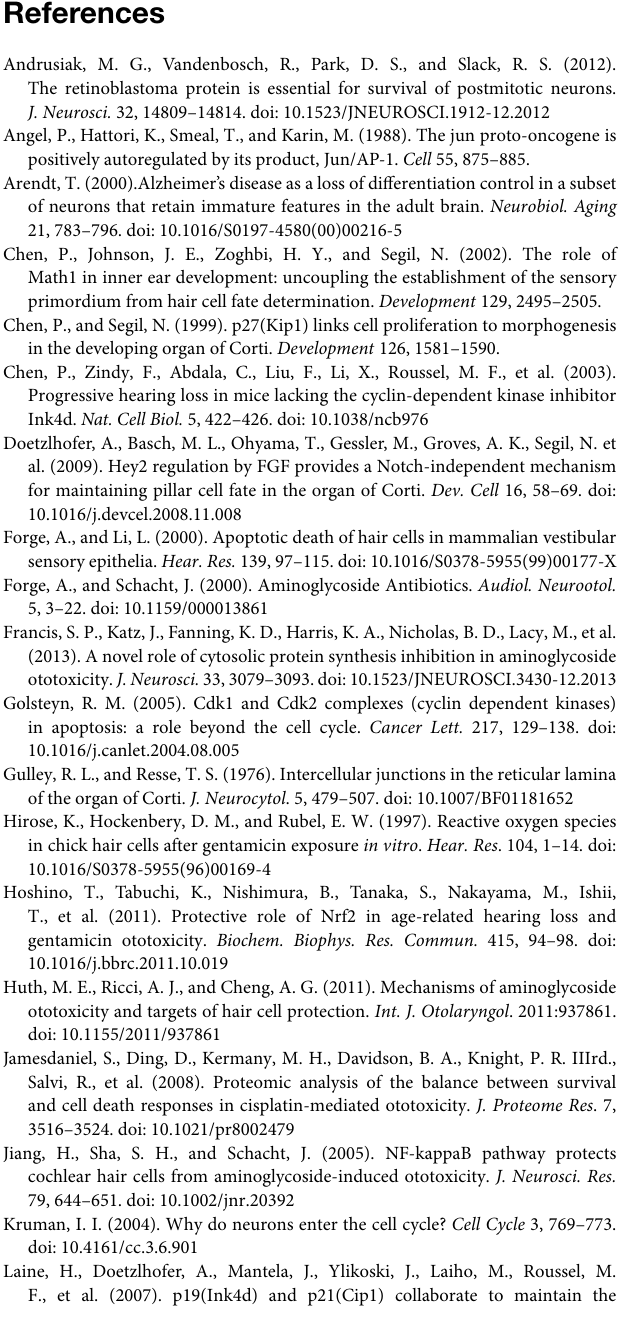
highlighted in yellow).